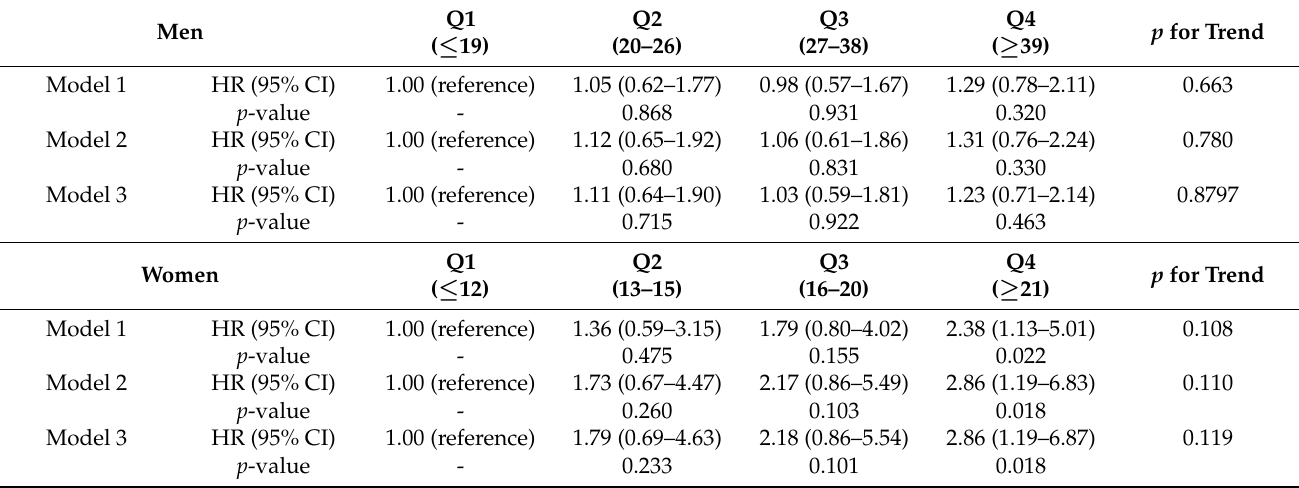
Table 3. Hazard ratios (95% confidence intervals) for the incidence of ischemic heart disease according to sex-specific GGT